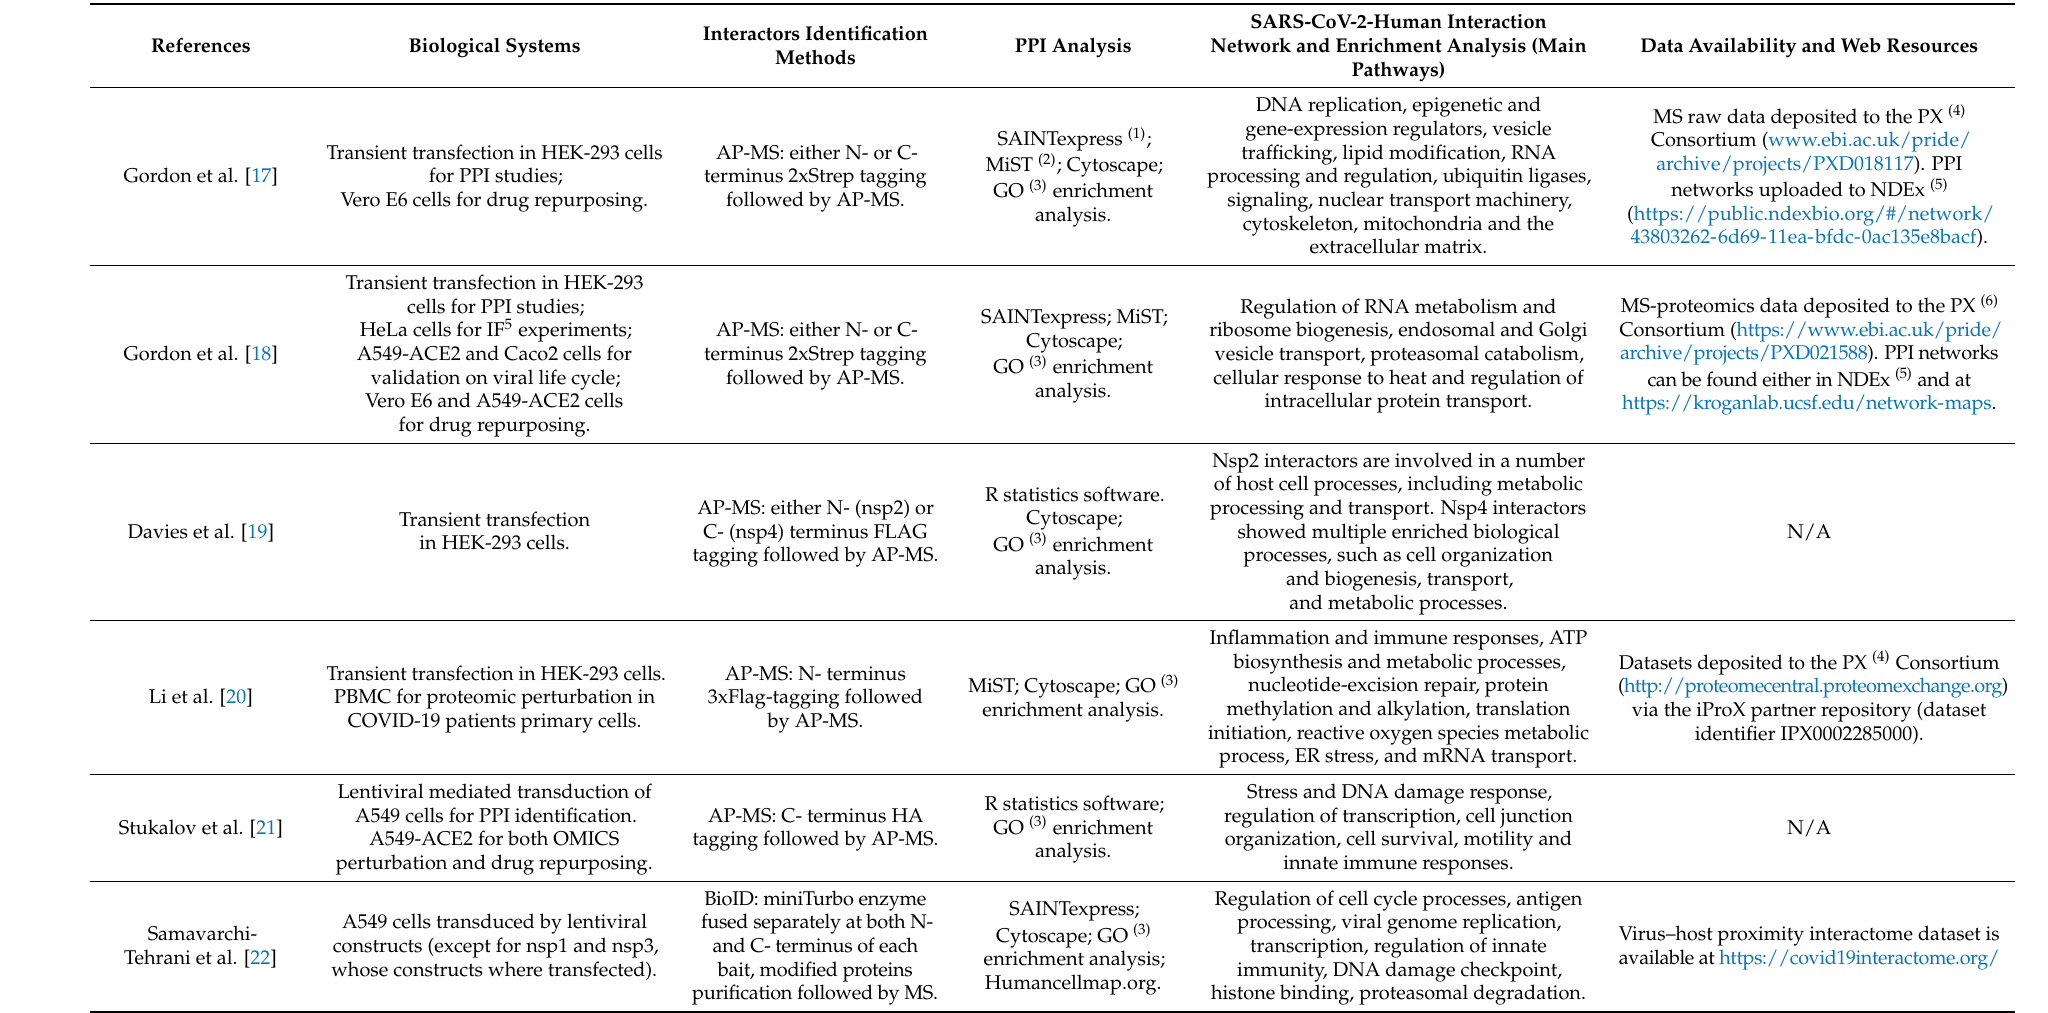
Table 1. Proteomics SARS-CoV-2 studies in cellular systems: network and enrichment